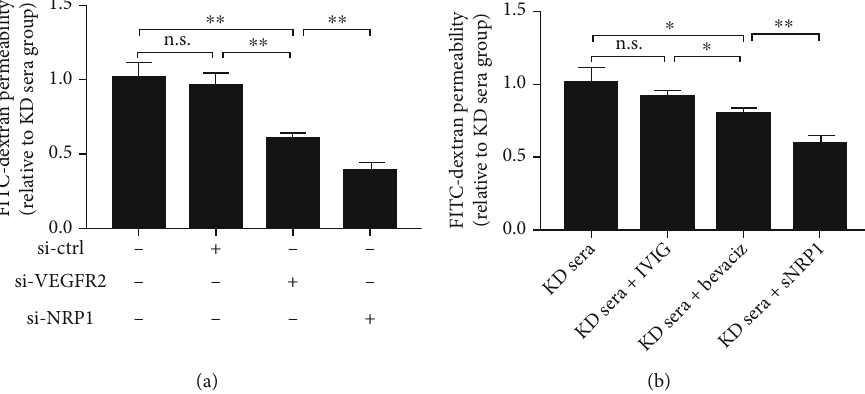
Figure 3: Downregulation of VEGFR2 or NRP1 blocks KD sera-induced hyperpermeability of HCAEC monolayers. (a) EC permeability assay upon transfection of control siRNA, VEGFR2 siRNA, or NRP1 siRNA and stimulation with medium containing 20% KD sera (pooled from 10 KD patients). (b) E ff ect of KD sera incubated with the indicated pharmacologic agent on EC permeability. Data are expressed as M ± SD from 3 separate experiments. ∗ P < 0 : 05 ; ∗∗ P < 0 : 01 ; n.s.: not signi fi